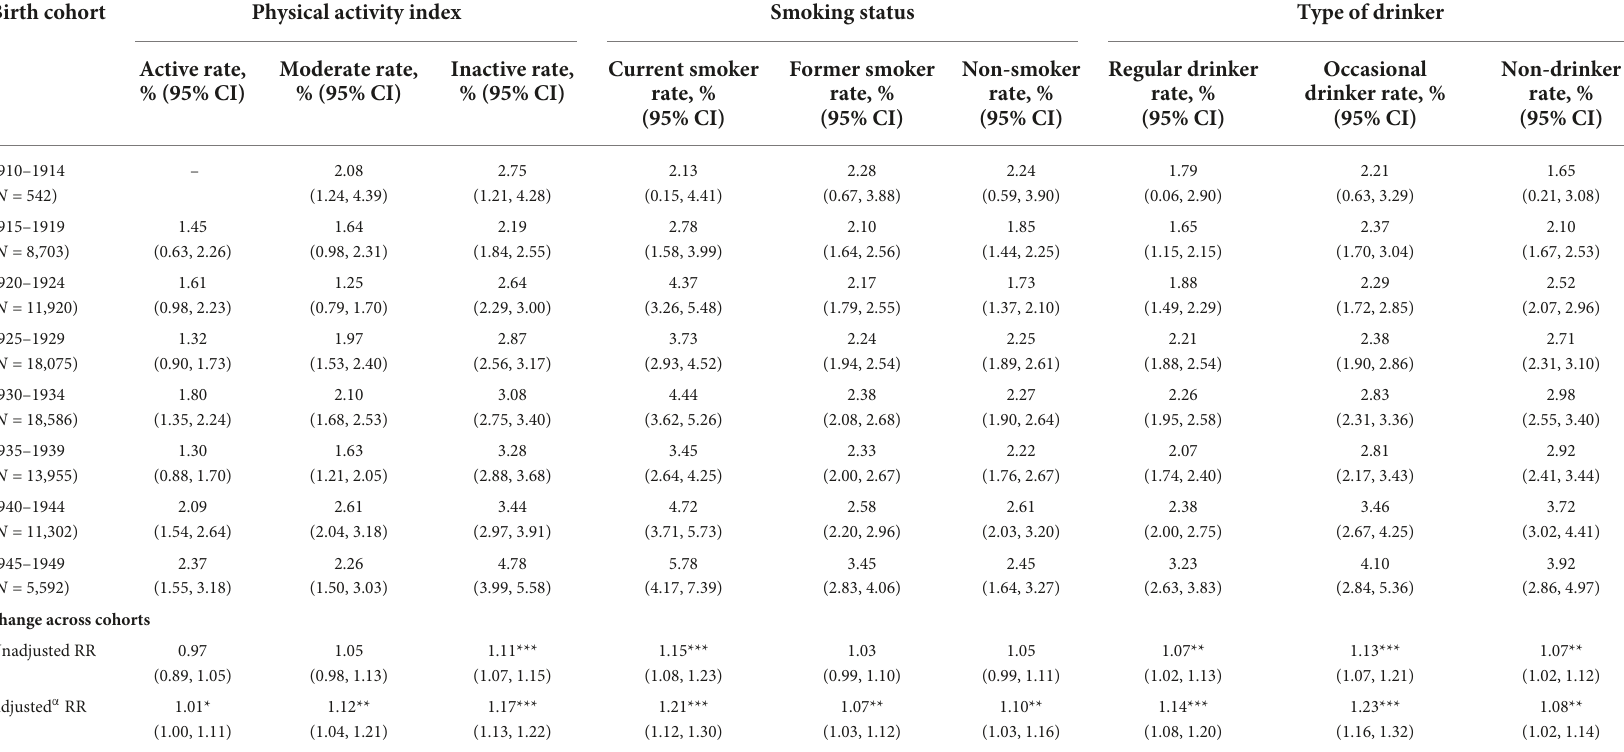
TABLE 3 Prevalence of depression by physical activity index, smoking status, and type of drinker across birth cohorts for Canadian residents 65+. Birth cohort Physical activity